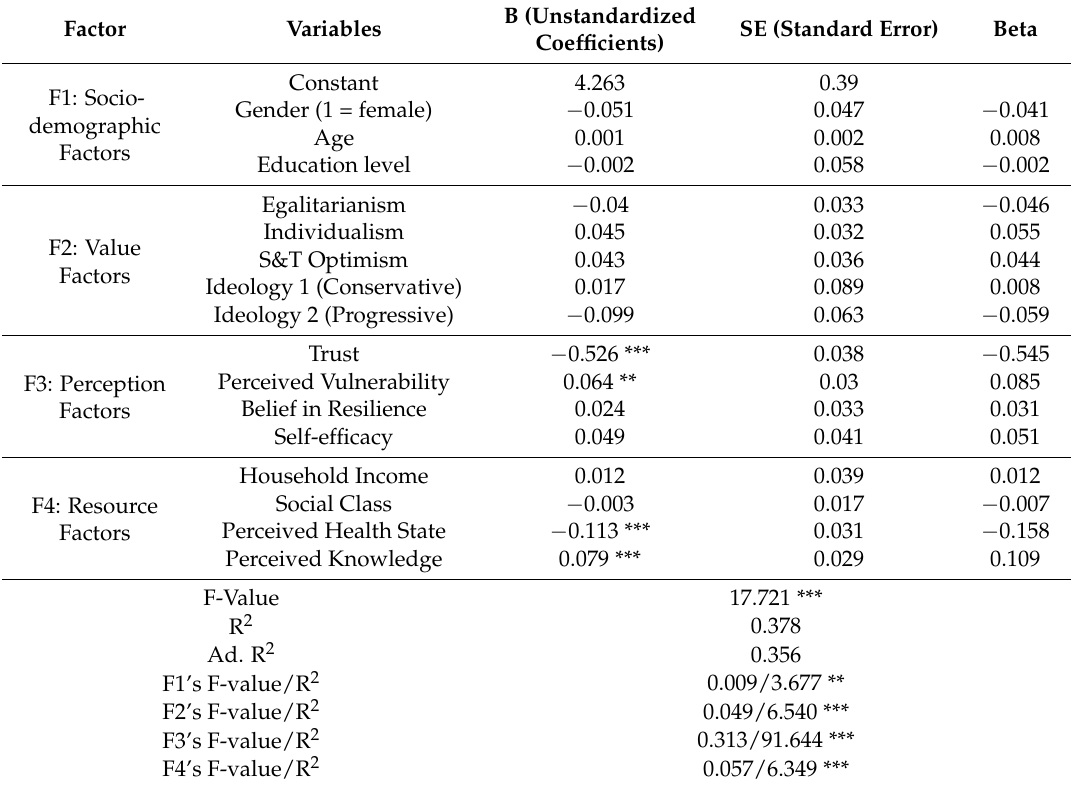
Table 4. Regression analysis: Perceived risk of MERS as dependent